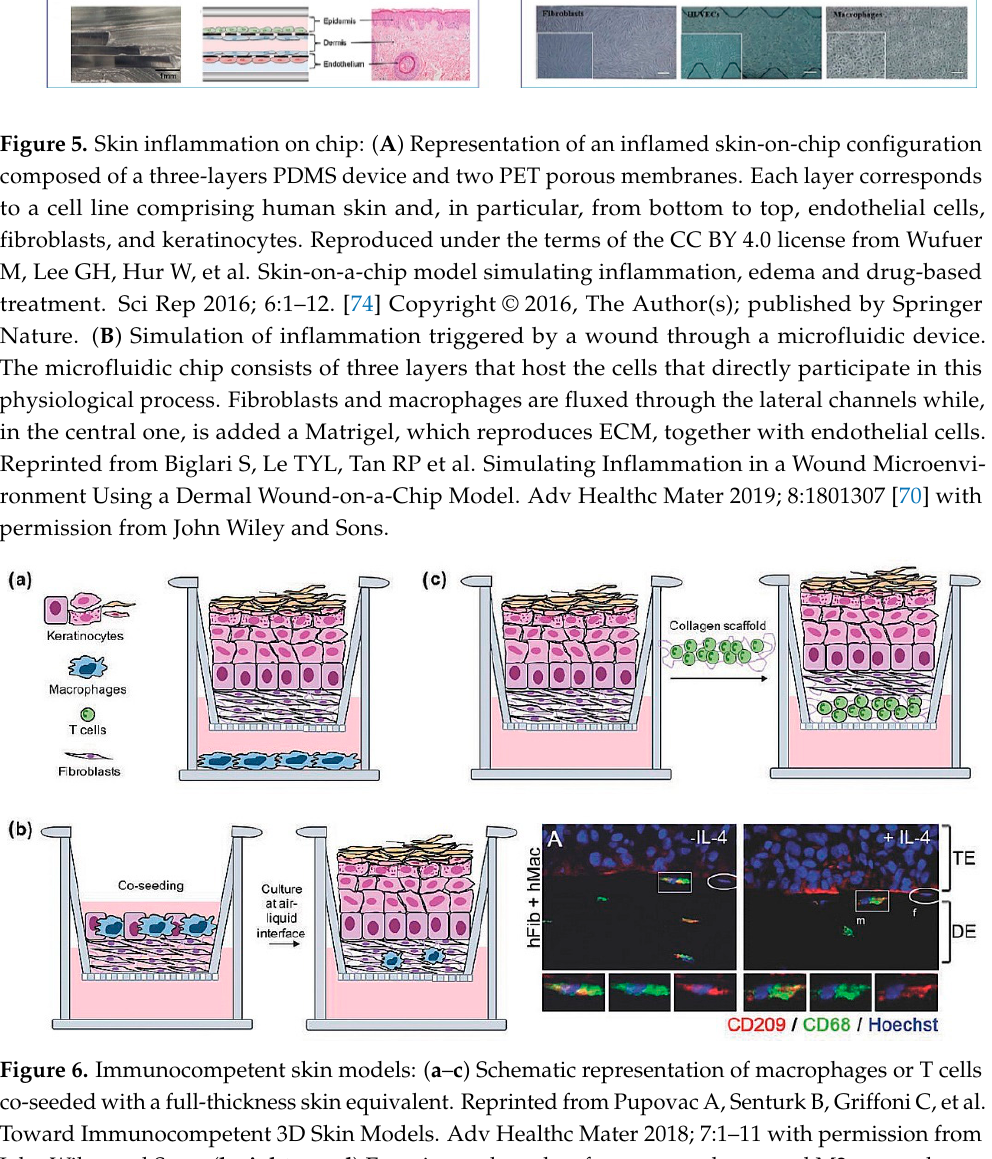
Figure 6. Immunocompetent skin models: ( a – c ) Schematic representation of macrophages or T cells co-seeded with a full-thickness skin equivalent. Reprinted from Pupovac A, Senturk B, Griffoni C, et al. Toward Immunocompetent 3D Skin Models. Adv Healthc Mater 2018; 7:1–11 with permission from John Wiley and Sons. ( b-right panel ) Experimental results of pan macrophages and M2 macrophages migration towards the epithelium. Reproduced under the terms of the CC BY 3.0 license from Linde N, Gutschalk CM, Hoffmann C, et al. Integrating macrophages into organotypic co-cultures: A 3D in vitro model to study tumor-associated macrophages. PLoS One 2012; 7. [84] Copyright © 2012, The Author(s); published by